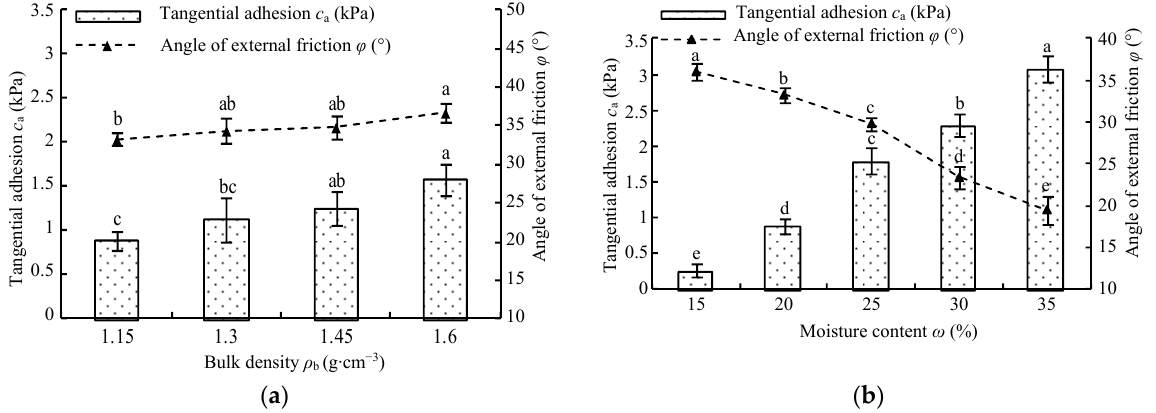
Figure 4. Changes in paddy soil adhesion between treatments: ( a ) variation of paddy soil in bulk density, and ( b ) variation of paddy soil in moisture content.